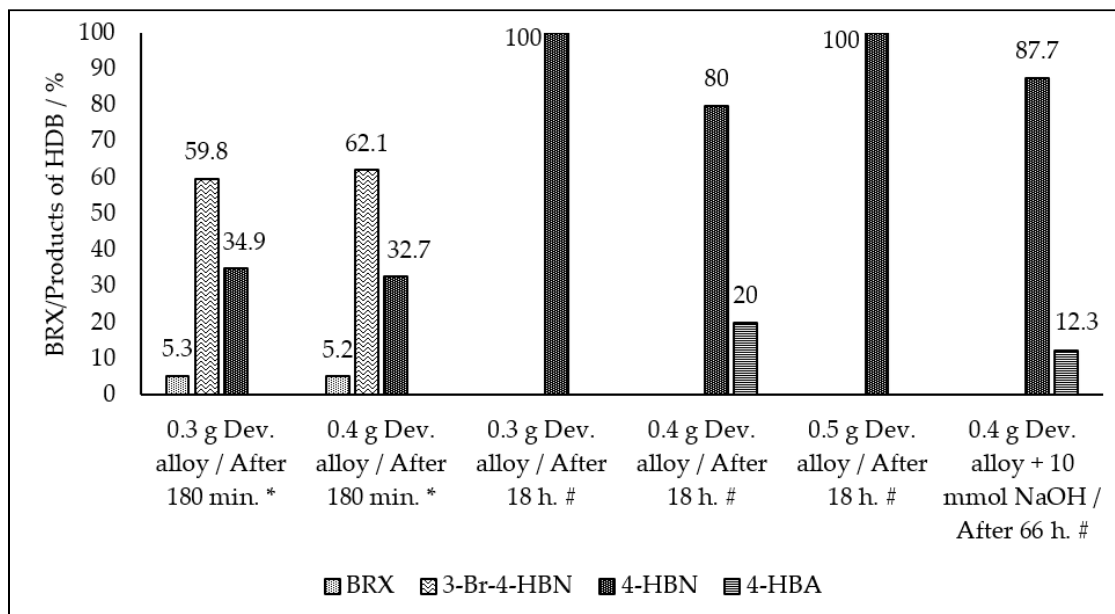
Figure 2. HDB of BRX using appropriate amount of Dev. alloy and NaOH. Dev. alloy was added to the solution containing 0.5 mmol BRX + 2 mmol NaOH in 100 mL H 2 O (*); or 0.5 mmol BRX + 10 mmol NaOH in 100 mL H 2 O (#).